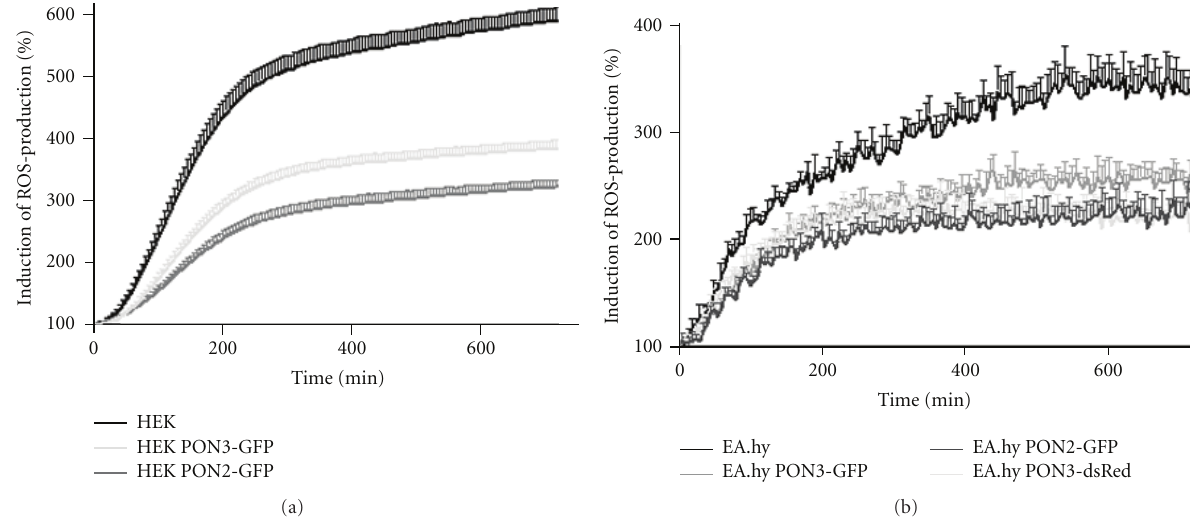
Figure 1: PON2 or PON3 overexpression diminishes ROS production induced by P. aeruginosa signaling molecule pyocyanin (PCN). (a) Na¨ıve, PON2-GFP, or PON3-GFP overexpressing HEK293 cells were loaded with carboxy-H 2 DCFDA and stimulated with PCN (2.4 μ M). Carboxy-H 2 DCFDA fluorescence as means of ROS was recorded over several hours. (b) Similar to A. Na¨ıve, PON2-GFP, PON3-GFP, or PON3-dsRed overexpressing EA.hy 926 cells were loaded with L-012 and stimulated with PCN (2.4 μ M). Curve maxima calculated by nonlinear regression showed statistically significant di ff erences ( P < 0 . 001) between na¨ıve and PON2 or PON3 overexpressing cells.